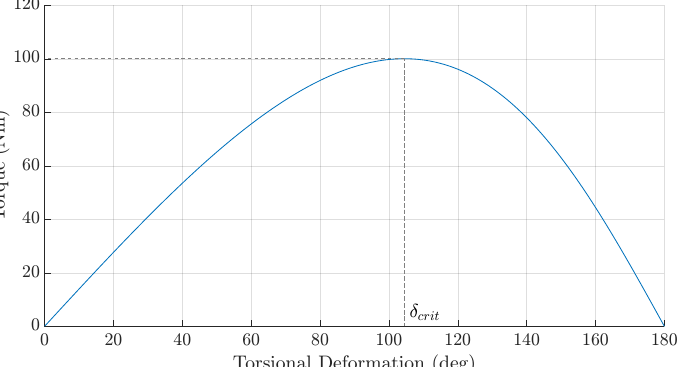
Figure 18. Amount of torque transmitted against the torsional deformation for a single TRPT section of the Daisy